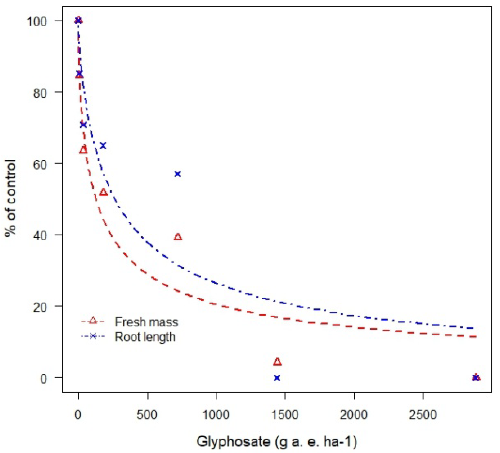
Figure 1. A. retroflexus fresh mass and root length as influenced by glyphosate dose 45 days after treatment (DAT).